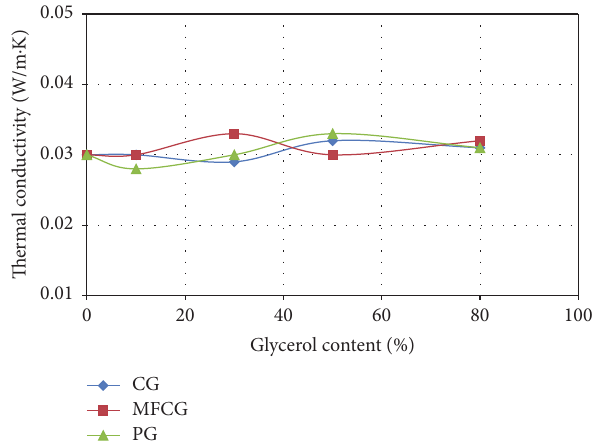
Figure9:TGAresultsforallPUFsampleswithmethanol-freecrude glycerol.